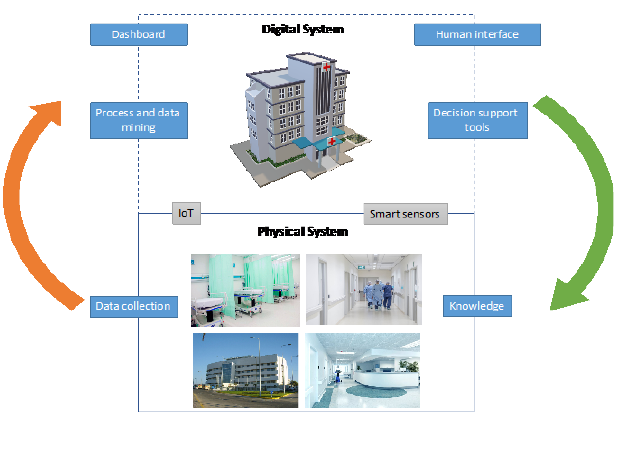
Figure 7. Hospitals Twins.